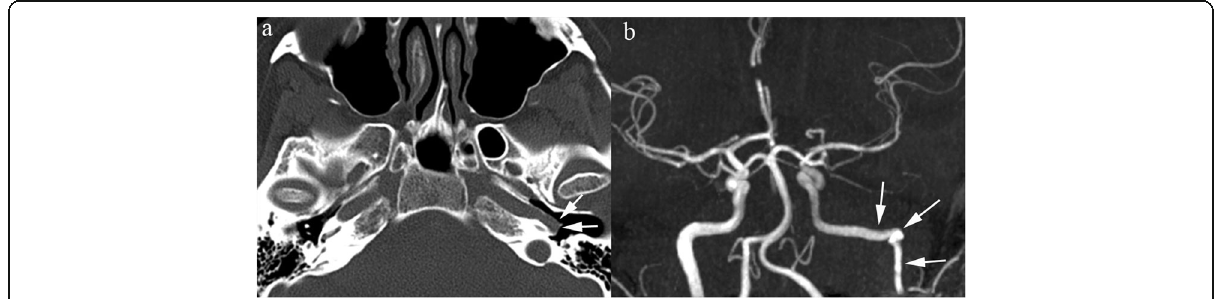
Fig. 12 Aberrant ICA. Axial MDCT scan ( a ) shows asymmetry of petrous ICA, the left coursing on the surface of the cochlear promontory (arrows). b MIP reconstruction in the coronal plane of a TOF sequence shows pinched contour of the ICA